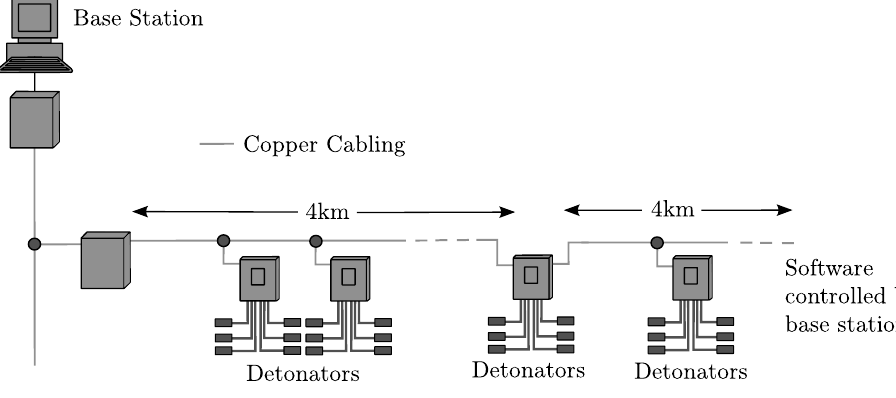
Figure 1: Schematic layout of the